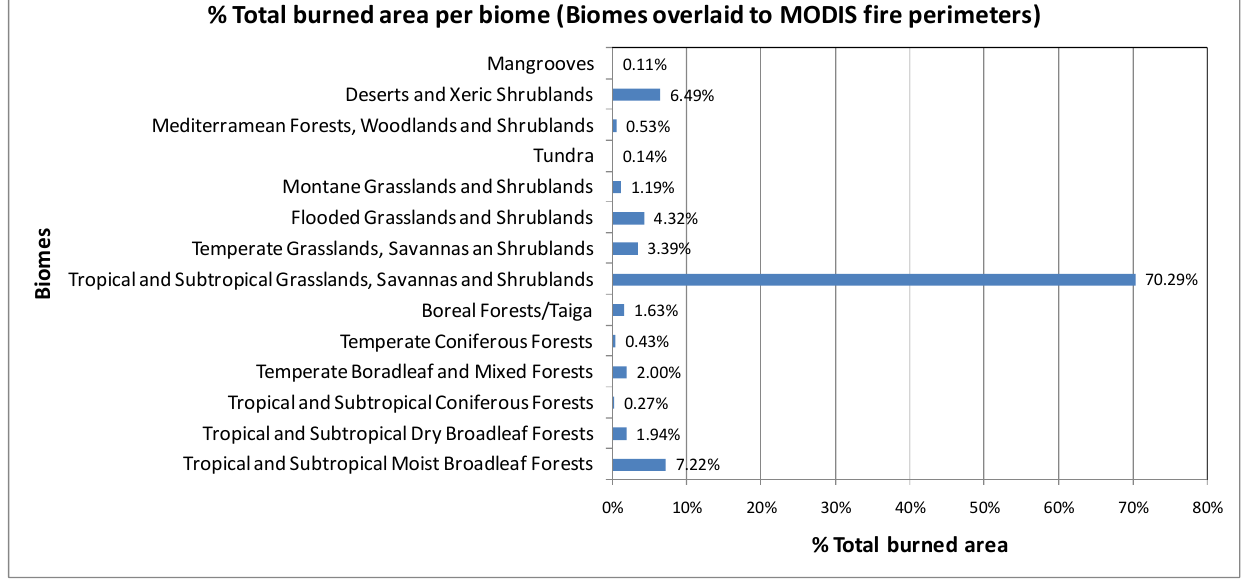
Figure 8. Total burned area per biome in percentages estimated after overlaying the biomes with MODIS fire perimeters.